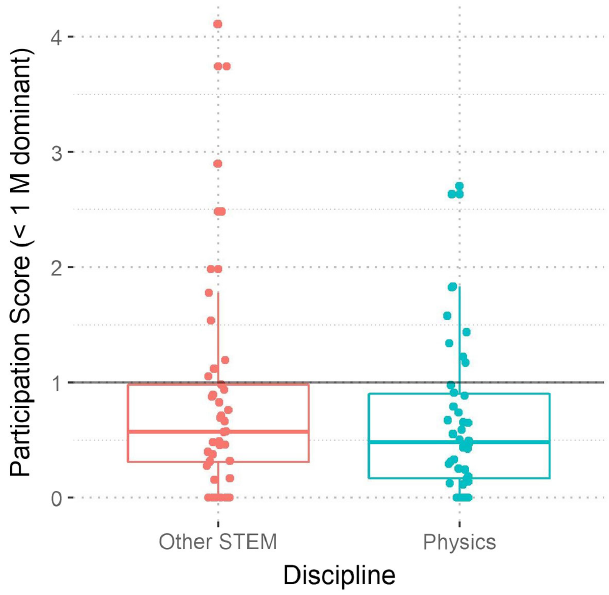
FIG. 6. Participation scores across all disciplines seem to show a disproportionate amount of men individually participating. Box-and-whisker plots of the participation scores in physics courses versus all other introductory STEM courses observed. Each point represents a class observation relative to the “ neutral ” participation score of one (horizontal line). The boxes show the median participation score in each category (center bar); the first and third quartiles (i.e., the 25 th and 75 th percentiles; “ hinges ” or outer lines of box), and 1.5 times the interquartile range ( “ whiskers ” or lines extending from boxes). While the other STEM courses had a higher average participation score ( M ¼ 0 . 85 ) than physics ( M ¼ 0 . 67 ), their means did not significantly deviate from each other ( W ¼ 939 . 5 , p ¼ 0 . 48 ), suggesting similar levels of gender inequity in individual par- ticipation across